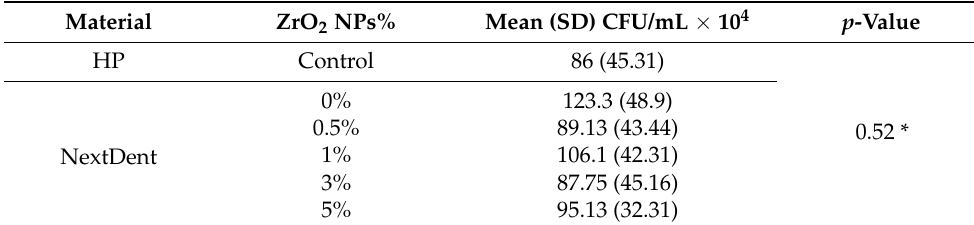
Table 2. Mean, SD, and significance of CFUs.